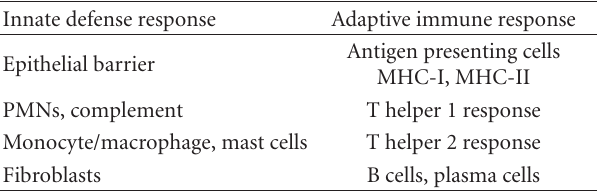
Table 2: Innate and adaptive defense in the periodontal